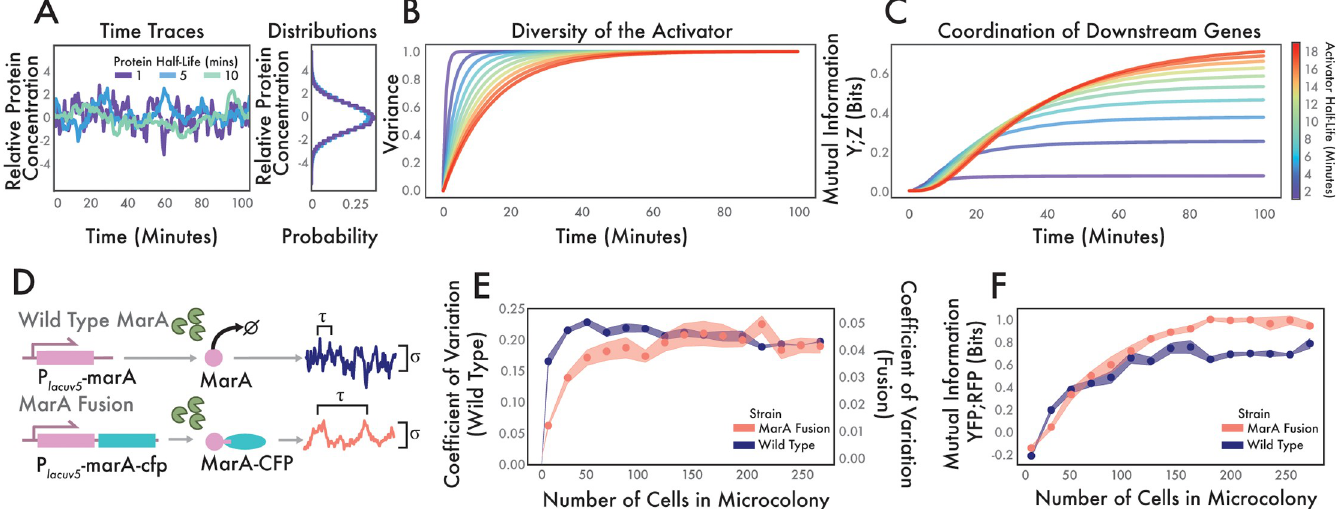
Fig 3. MarA-CFP fusion shows different downstream statistics than wild type MarA, even at similar expression levels. (A) Simulation of how modulating the half- life of regulator X affects correlation time. Sample trajectories with varying half-lives but constrained population variance produce the same distributions (right). (B) Analytical solutions for the variability of a protein as a function of time and half-life. (C) Analytical solutions for the coordination of two downstream genes as a function of differing activator half-lives. (D) Experimental schematic comparing wild type and MarA fusion systems. Top row indicates wild type system. Bottom row indicates protection of MarA from active degradation by Lon via a translational fusion with CFP. This modification changes the correlation time τ compared to wild type. IPTG induction of the LacUV5 promoter allows us to adjust σ independently of τ . (E) Experimental results showing growing variability of wild type and MarA fusion strains. (F) Experimental results of growing coordinated diversity of wild type and MarA fusion. For (E) and (F) dots show mean coefficient of variation over n = 5 growing microcolonies. Shaded regions show standard error. S4 Fig shows the scatter plots of the final time point for both of these strains.